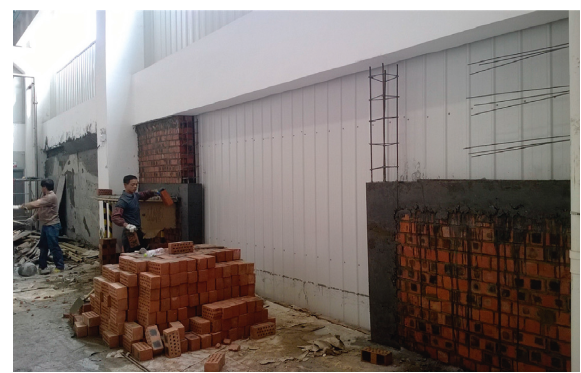
Figure 9: Short-pier shear walls in construction.